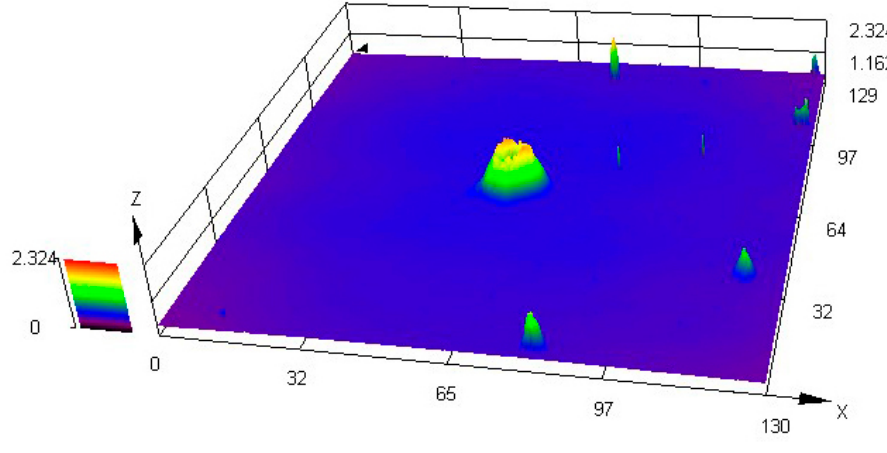
Figure 14. LSCM images of the large spot.